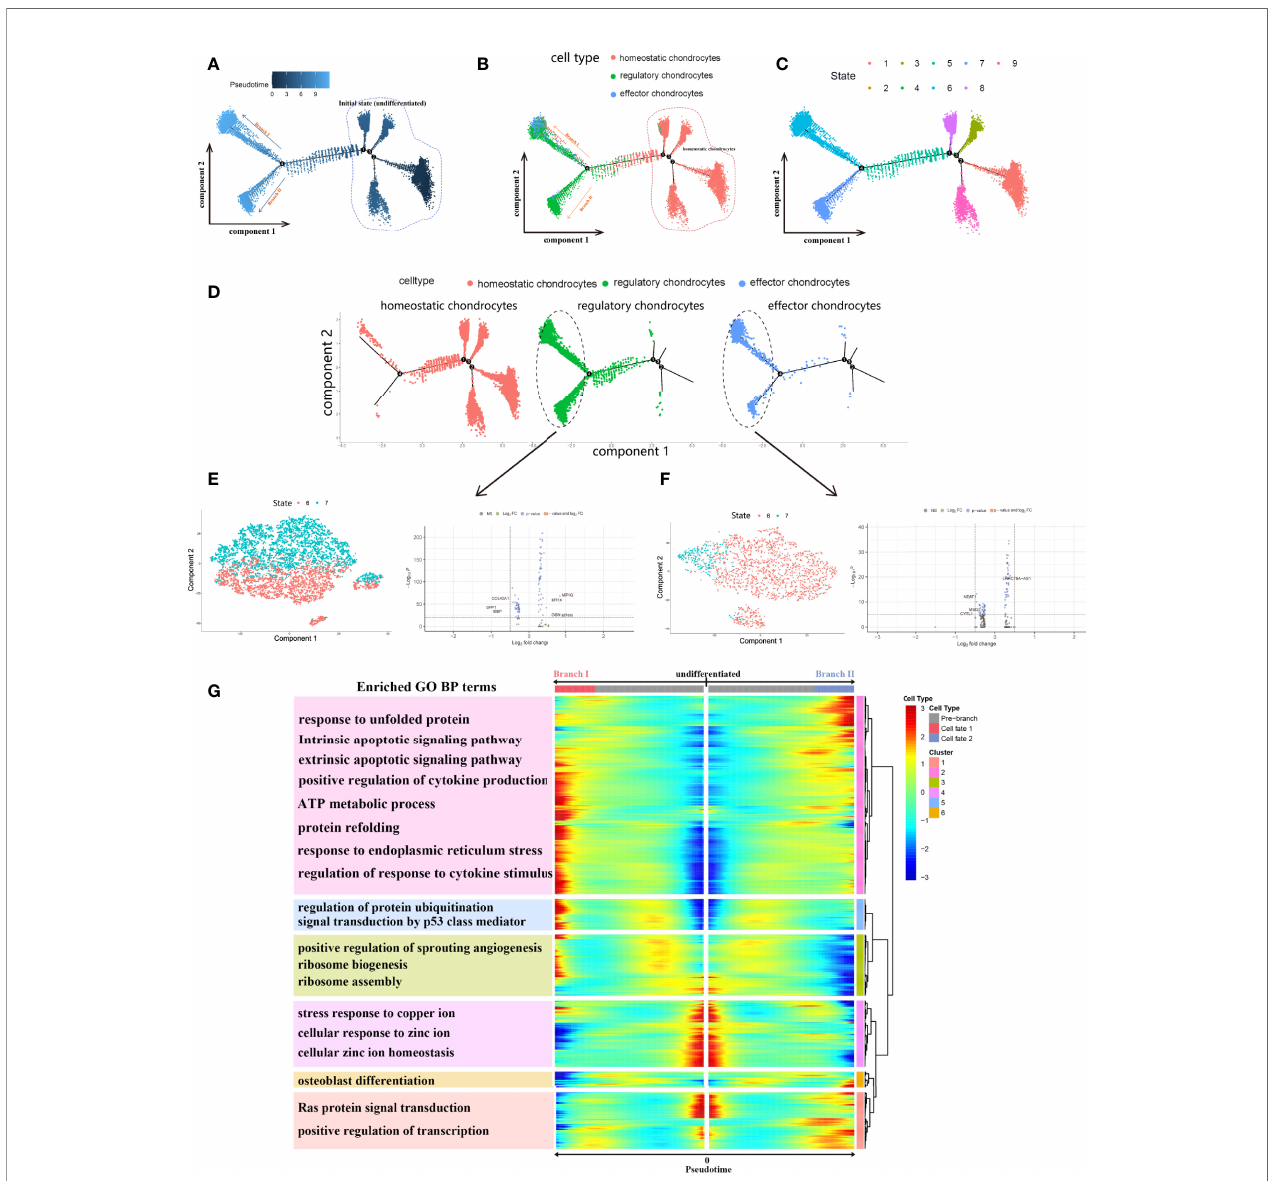
FIGURE 8 | Monocle pesudotime trajectories analysis revealed the chondrocytes cell lineage progression. (A) , Trajectory differentiation diagram based on cell differentiated state, dark dots represented the initial state (marked by circle) and light dots represented different 2 cell fates (branch I and II). (B, C) , Trajectory differentiation diagram colored by cell types and differentiated states. Cells within initial state were homeostatic chondrocytes. (D) , the detailed distribution of different chondrocytes in trajectory plot during differentiation. (E, F) , PCA dimension reduction of regulatory and effector chondrocytes based on state 6 and 7, respectively, and differential analysis of genes. (G) , Branch trajectory heatmap of the DEGs revealed the gene alterations under different cell differentiation states. The main functions of genes in each cluster were also